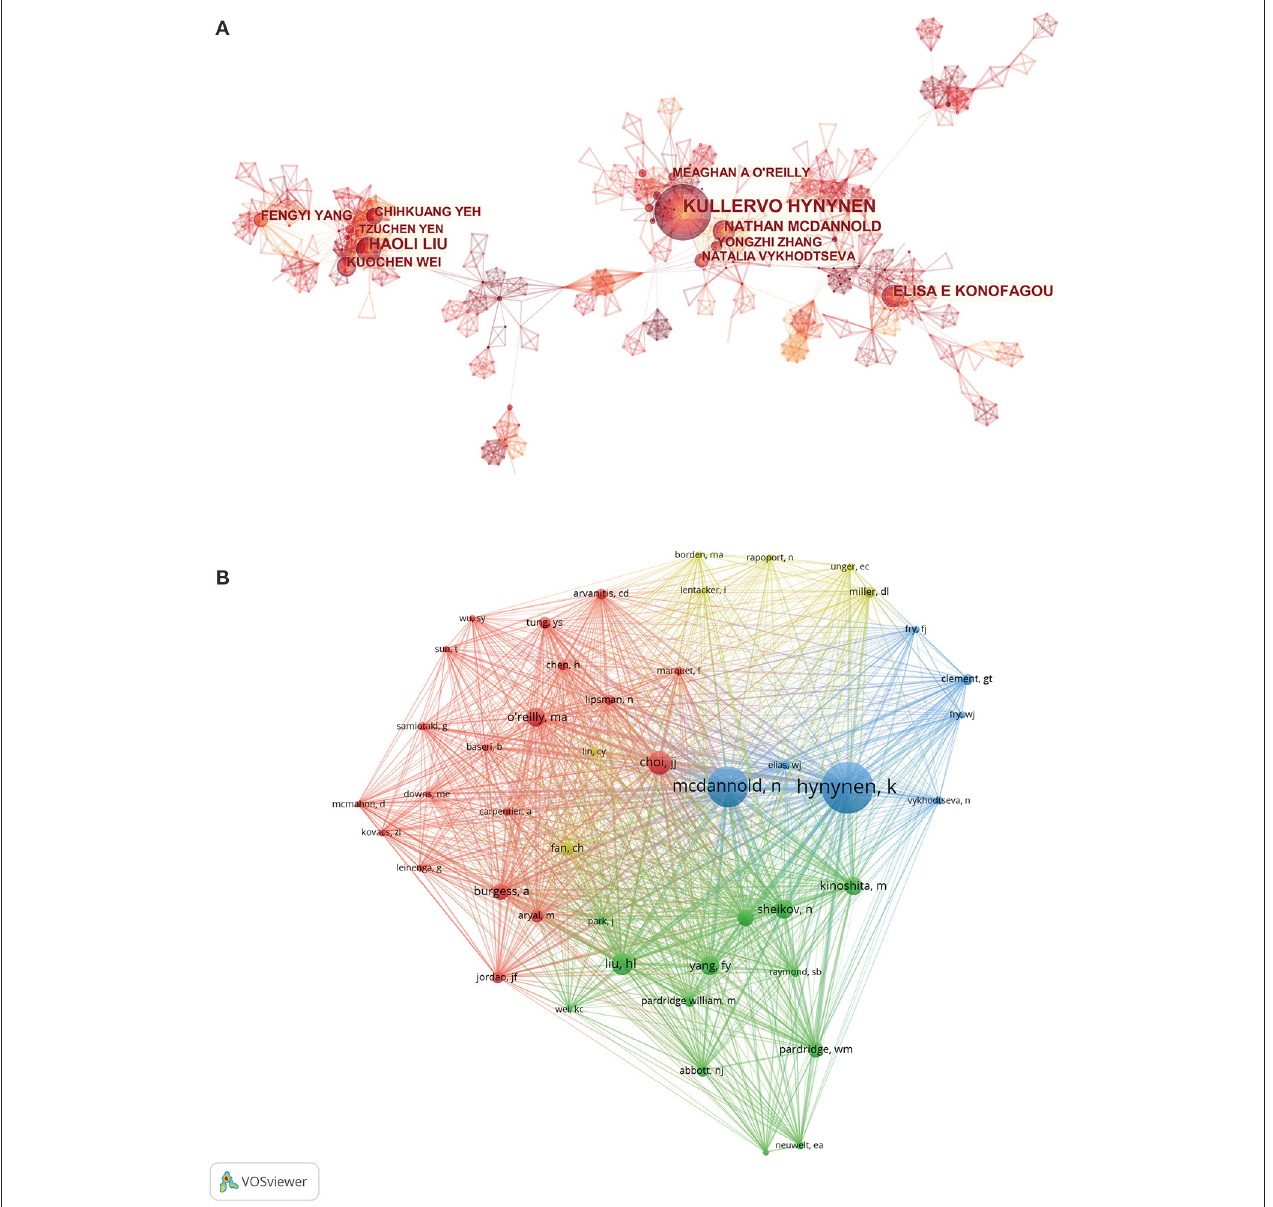
FIGURE 6 | (A) The cooperation network visualization map among productive authors analyzed by CiteSpace. (B) The co-citation analysis of the authors carried out by using VOS